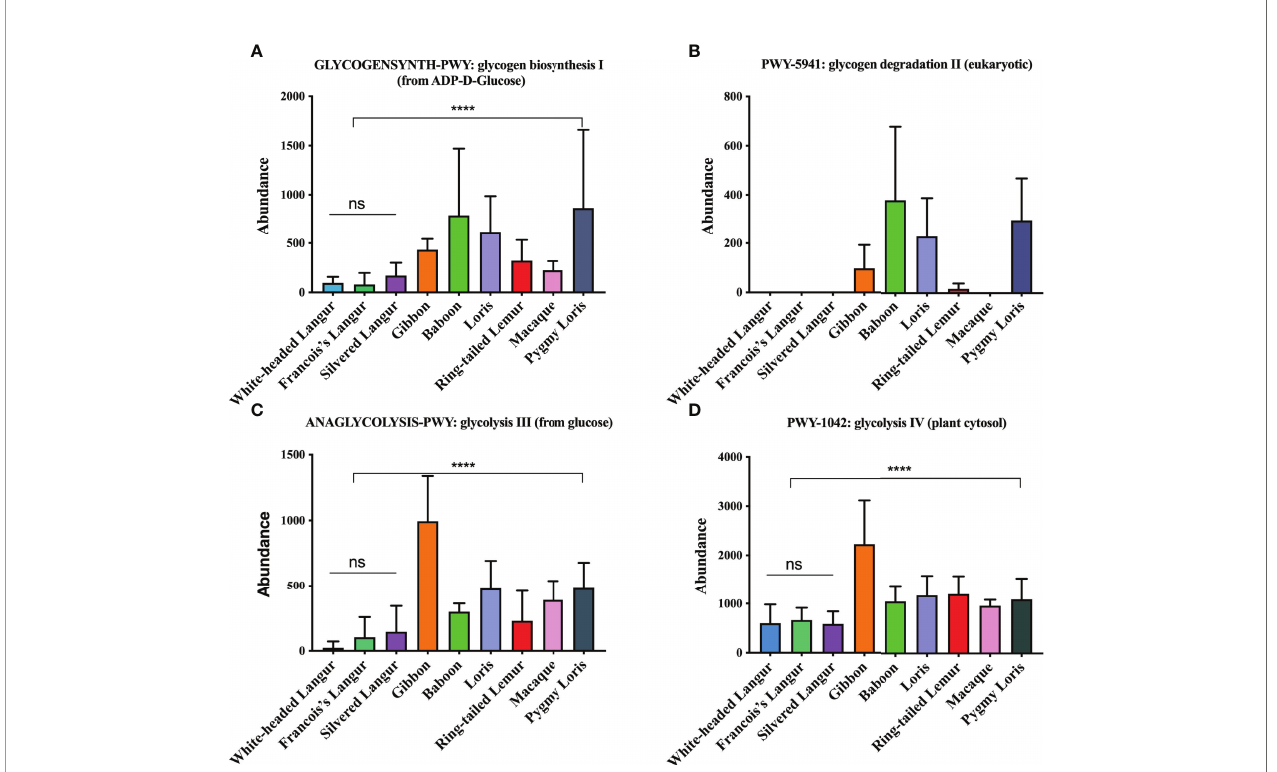
FIGURE 8 | Metabolic pathways of the gut microbiome in all primates. (A) GLYCOGENSYNTH-PWY:glycogen biosynthesis I (from ADP-D-Glucose). (B) PWY-5941: glycogen degradation II (eukaryotic). (C) ANAGLYCOLYSIS-PWY:glycolysis III (from glucose). (D) PWY-1042:glycolysis IV (plant cytosol). ns represents no signi fi cant difference; **** represents P <